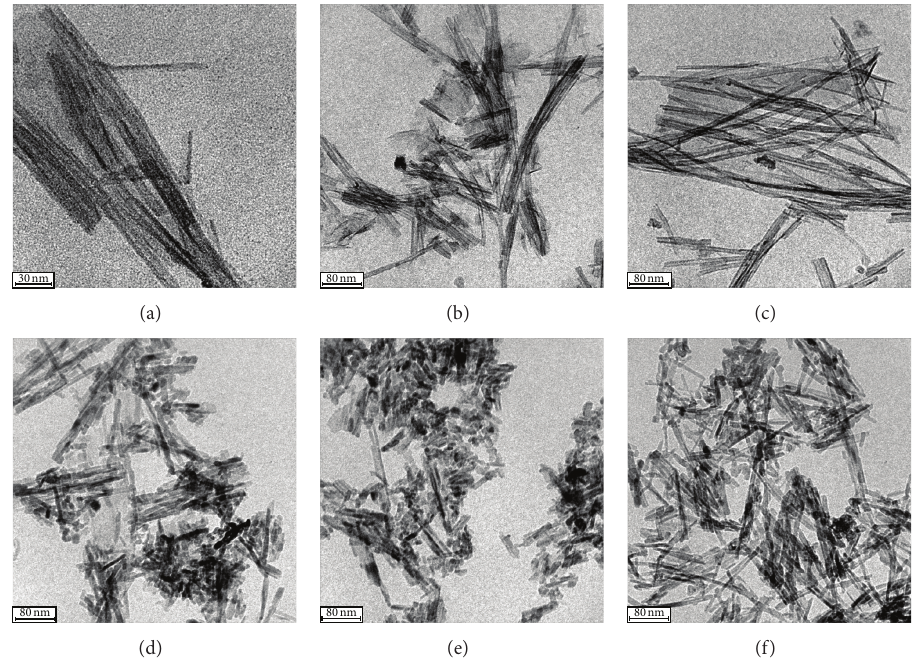
Figure 2: TEM images of the uncalcined ((a): 1%; (b): 2%; (c): 5%) and calcined ((d): 1%; (e): 2%; (f): 5%) samples with different Sr/Ti ratios.